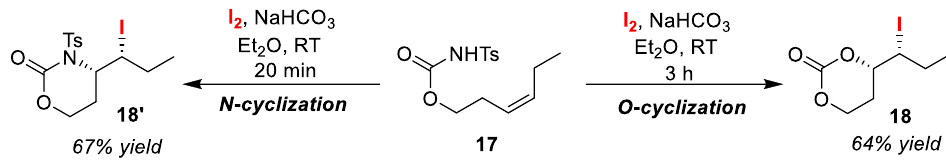
Figure 9. Time-dependent O / N atom-selective iodo-cyclizations of olefinic N -tosyl carbamates 17 .